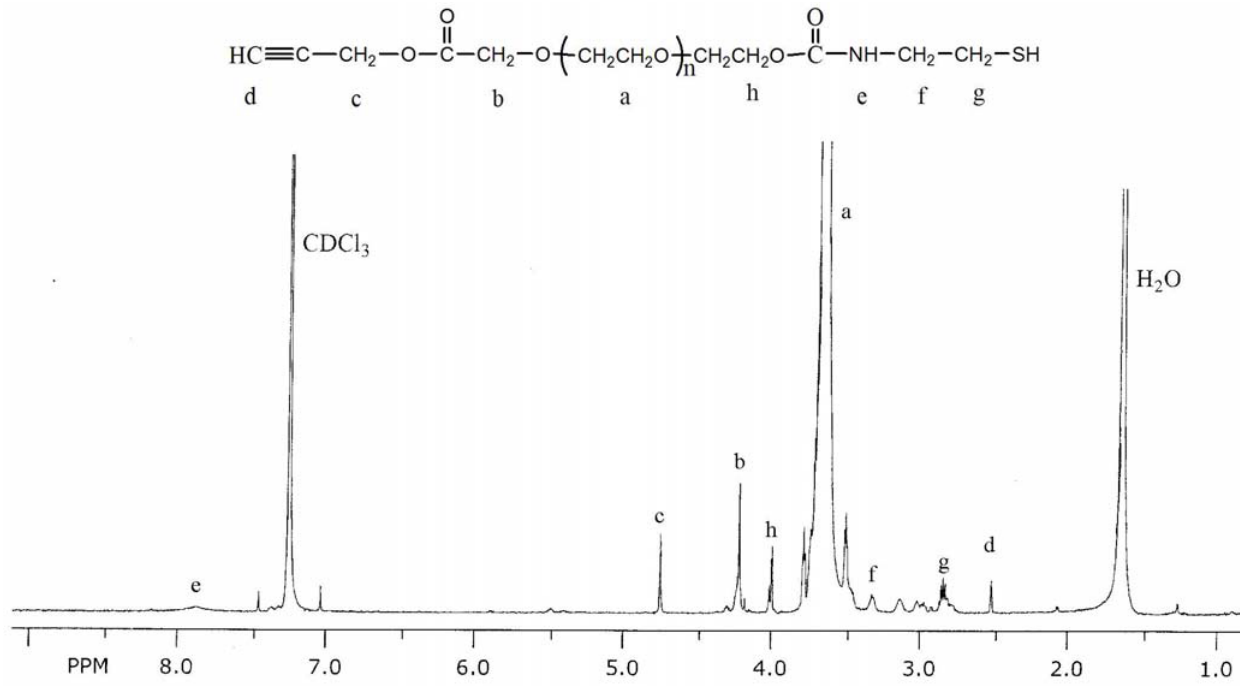
Figure 6. 1 H NMR spectrum of poly(ethylene glycol) with ω -propargyl group and α - thioglycol